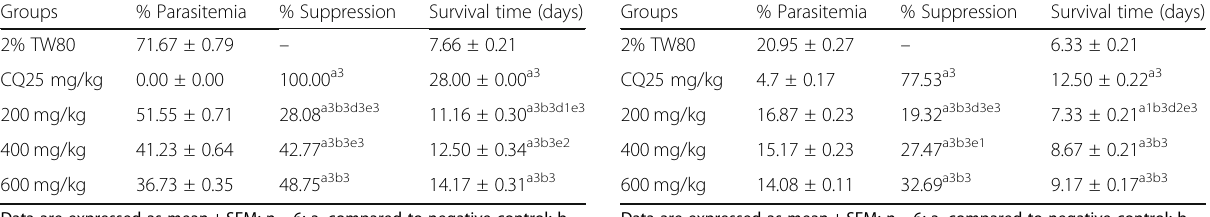
Table 4 Packed cell volume, rectal temperature and body weight of infected mice treated with 80% methanol extract of the leaves of Olea europaea in Rane ’ s test Groups Packed cell volume Rectal temperature